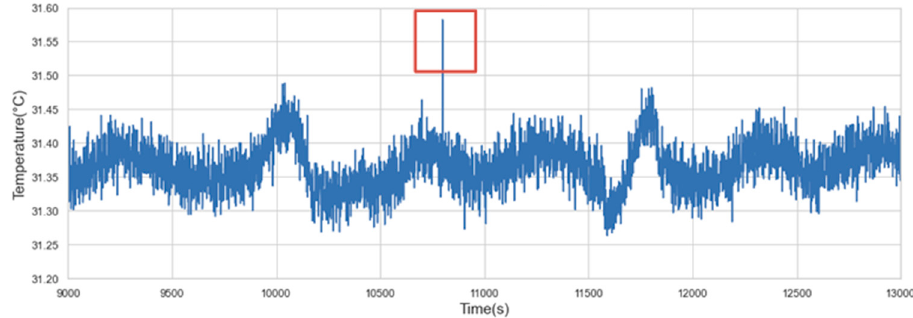
Figure 5. Point anomaly.